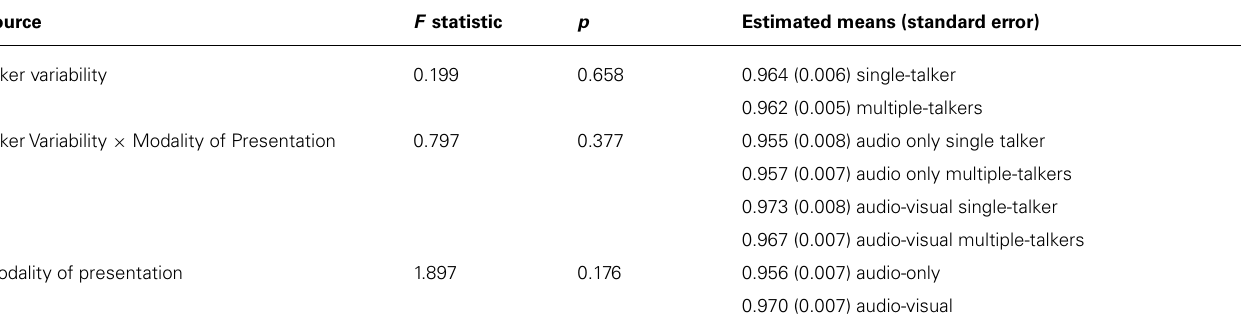
Table 2 | Summary of results from the split plotANOVA [TalkerVariability (Single-Talker vs. Multiple-Talkers) × Modality of Presentation (Audio-only vs.Audio-visual), withTalkerVariability as a within-subject factor and Modality of Presentation as a between-subject factor] for the dependent measure of hit rates.